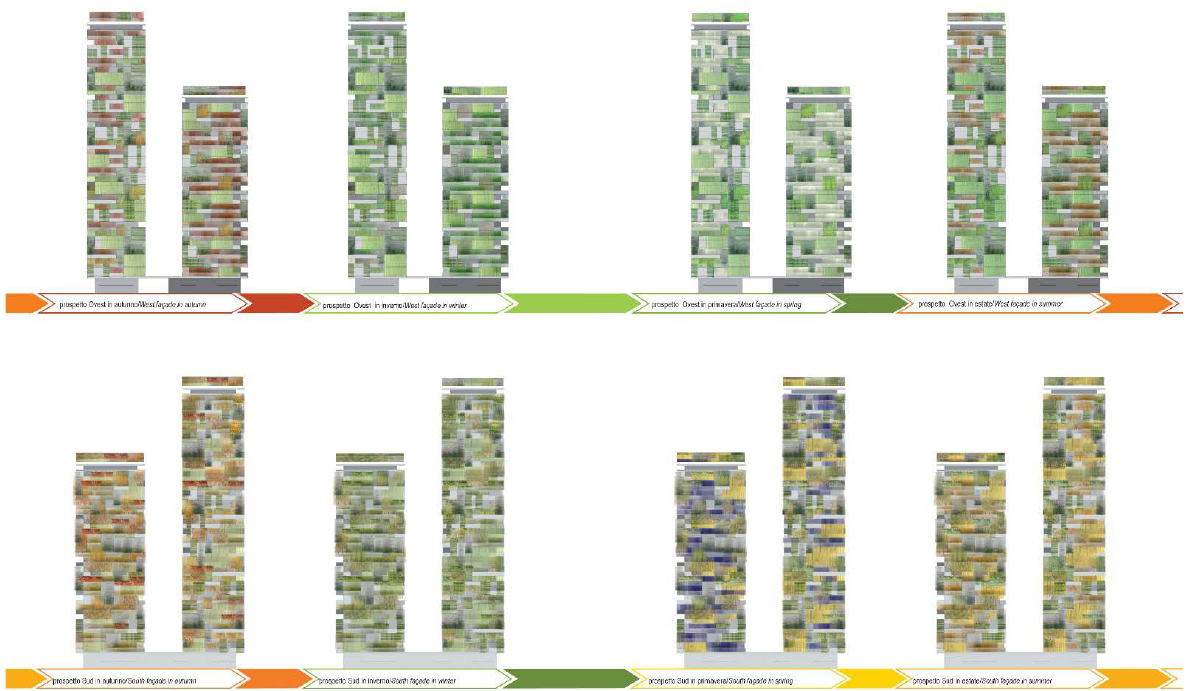
Figure 6. Seasonal change (autumn, winter, spring, summer (left to right)) of the facades of Bosco Verticale, represented by the west façade ( top ) and the south façade ( bottom ) (Stefano Boeri Architetti 2009).